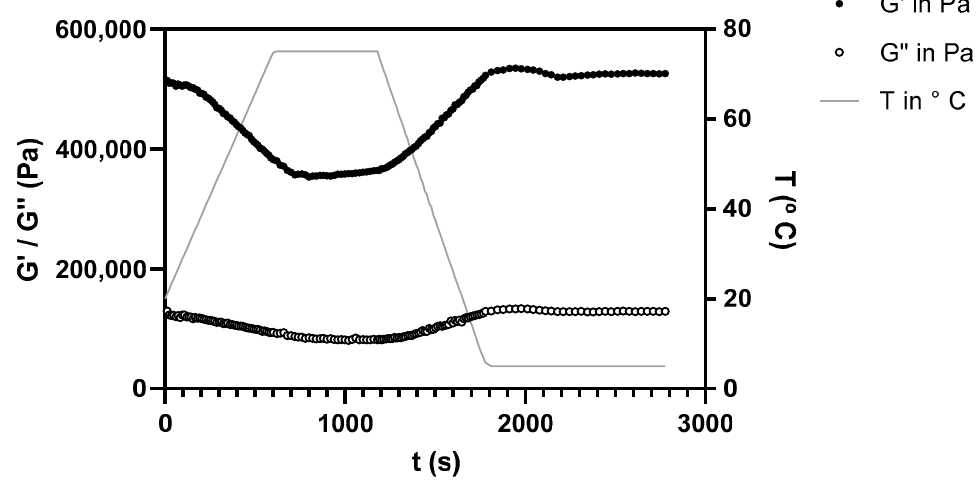
Figure 4. Evolution of storage modulus (G ′ ) for pear pomace paste (PP) at 2 π rad/s upon application of a thermal cycle (continuous line).